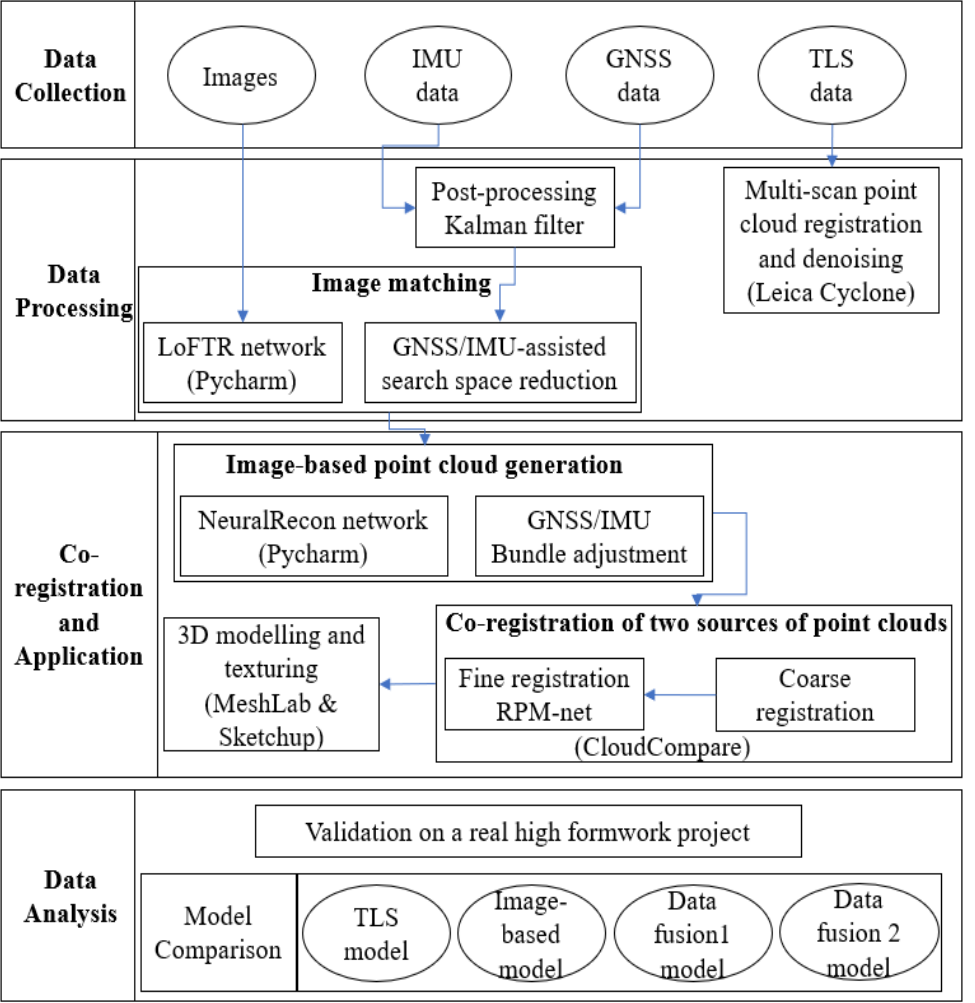
Figure 1. The proposed methodology workflow.